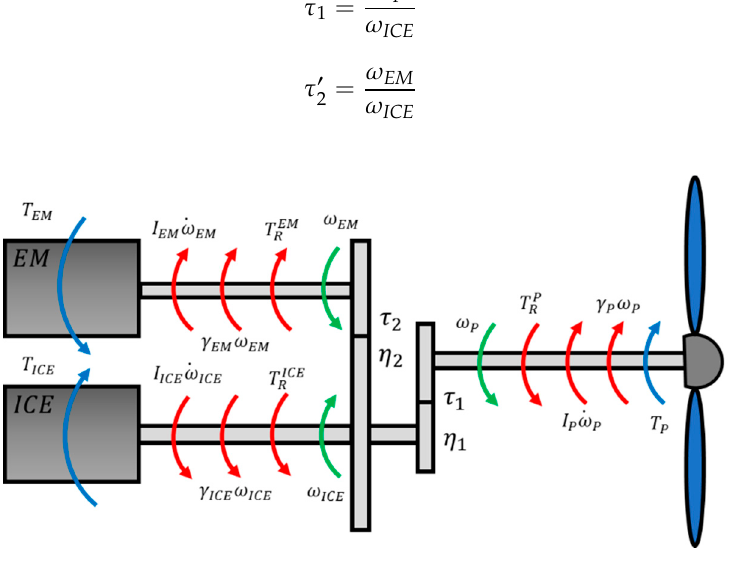
Figure 3. Torques acting on the hybrid propulsion architecture during power boost.